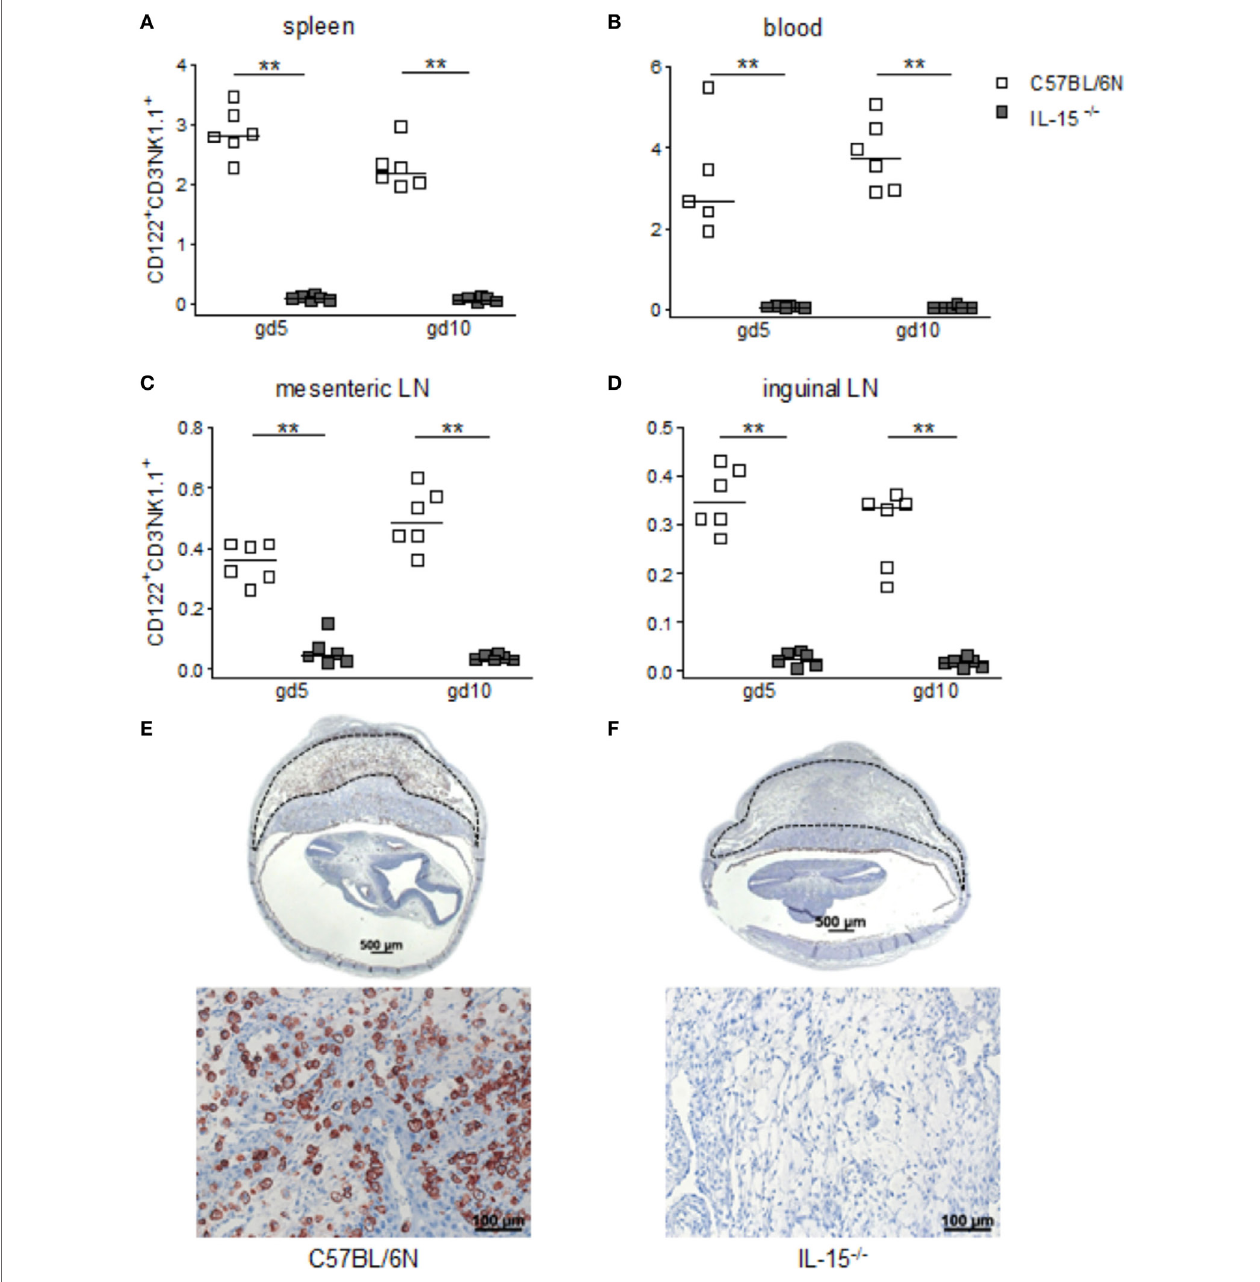
FigUre 2 | Interleukin (IL)-15-deficient mice are characterized by very low levels of peripheral (p) and the absence of uterine natural killer cells (uNKs) in contrast to wild-type mice. Percentages of CD122 + CD3 − NK1.1 + pNKs in spleen (a) , blood (B) , mesenteric lymph nodes (LN) (c) , and inguinal LNs (D) at gd5 and gd10 were analyzed by flow cytometry in samples from C57BL/6N ( n = 5–6) or IL-15 − / − ( n = 6) mice. Results are presented with squares showing the individual values for each mouse and medians are indicated. Statistical analysis was performed by the Mann–Whitney U -test (** P < 0.001). Representative Dolichos biflorus agglutinin (DBA) lectin-stained cross sections of implantations from C57BL/6N (e) or IL-15 − / − (F) mice at gd10 are depicted (scale bar = 500 μ m). uNKs can be identified as DBA lectin-positive, brown-stained cells within the decidua basalis (dashed lines marked area). Lower pictures show cutouts from the decidua basalis with higher magnification (scale bar = 100 μ m) (F) confirms the absolute NK absence at gd10. IL, interleukin; p, peripheral; u, uterine; LN, lymph nodes; DBA, dolichos biflorus